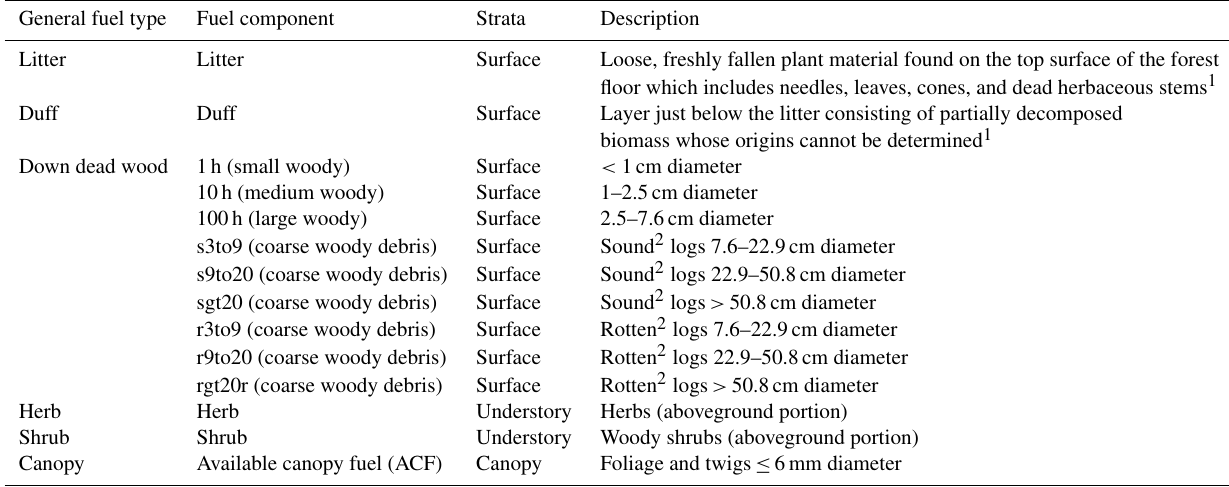
Table 3. Description of fuel components.